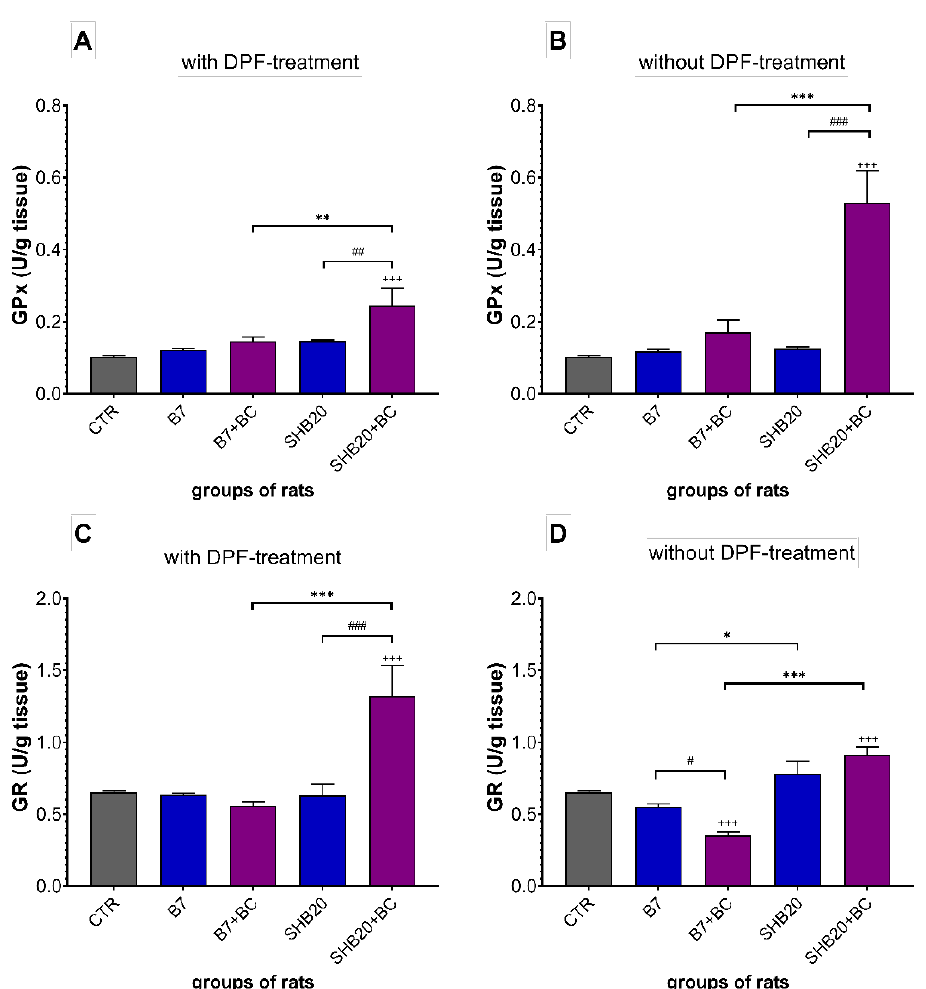
Figure 8. The activity of glutathione peroxidase (GPx) ( A , B ) and glutathione reductase (GR) ( C , D ) in the testes of rats exposed to DEE from B7 or SHB20 biofuels with or without DPF-treatment and with or without blackcurrant pomace supplementation (BC) for 28 days. Data are expressed as mean ± SEM. # — Statistically significant difference between normal and blackcurrant pomace supple- mented diet, ## p < 0.01; ### p < 0.001; * — Statistically significant difference between B7 and SHB20